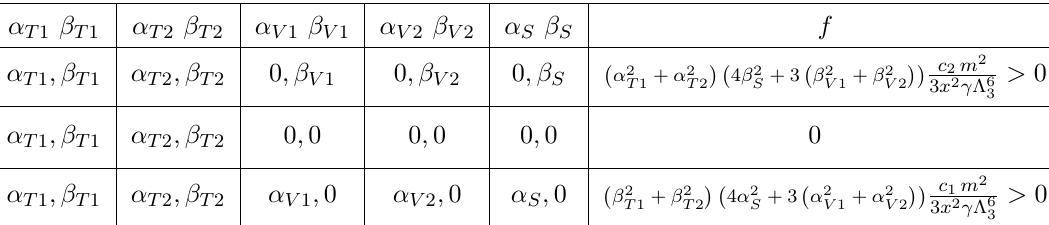
Table 2 . Special con(cid:12)gurations of polarizations for hf ! hf scattering. The (cid:12)rst and the third row show that the cubic couplings c i must be positive. The second row indicates that pure tensor states do not impose constraints on the leading order interactions, but could be used to put constraints on contributions from sub-leading operators not included in our